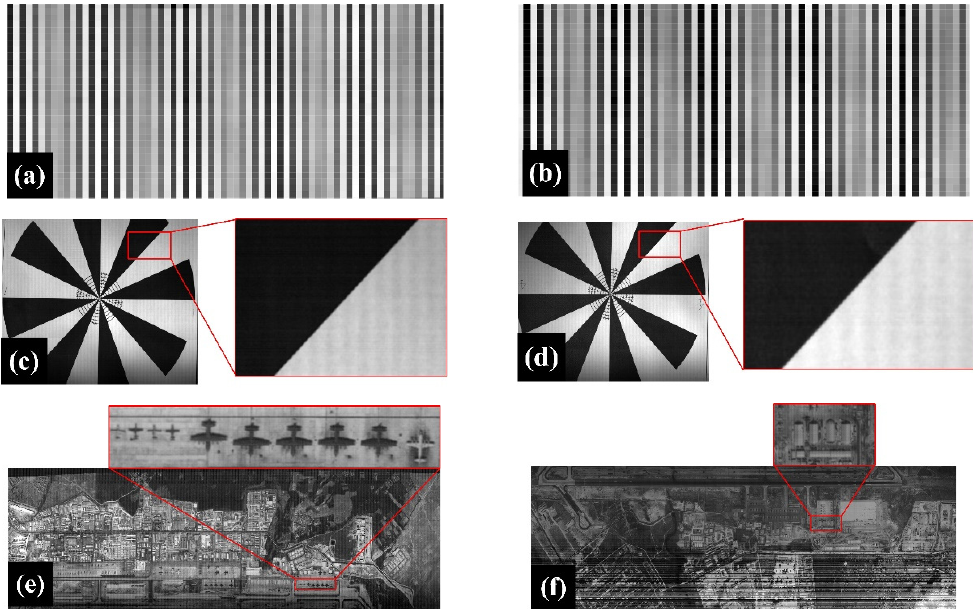
Figure 6. Experimental results: ( a ) Resolution image of detector 1; ( b ) Resolution image of detector 2; ( c ) Edge image of detector 1; ( d ) Edge image of detector 2; ( e ) Color image of detector 1; ( f ) Color image of detector